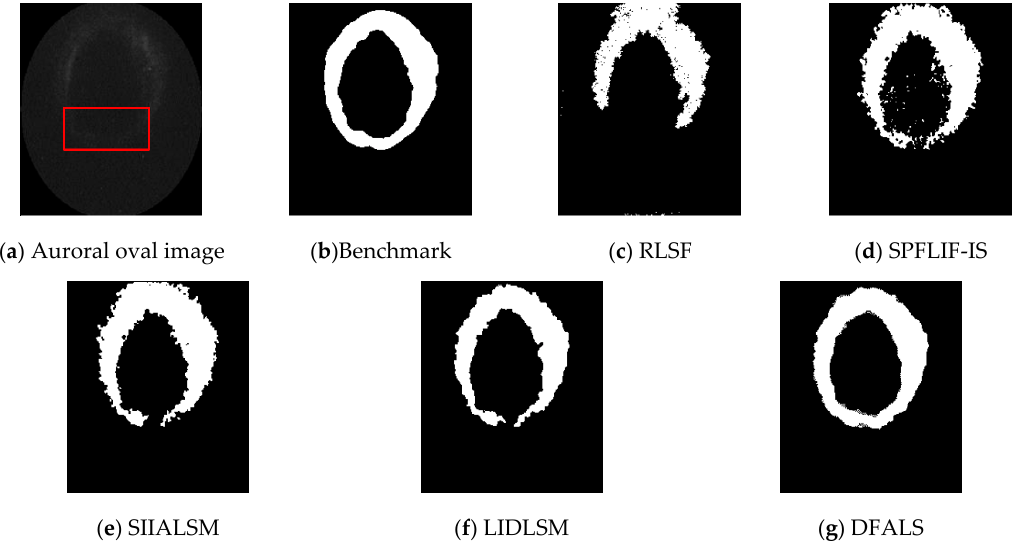
Figure 12. The segmentation results of di ff erent methods. ( a ) UVI image captured by polar satellite on